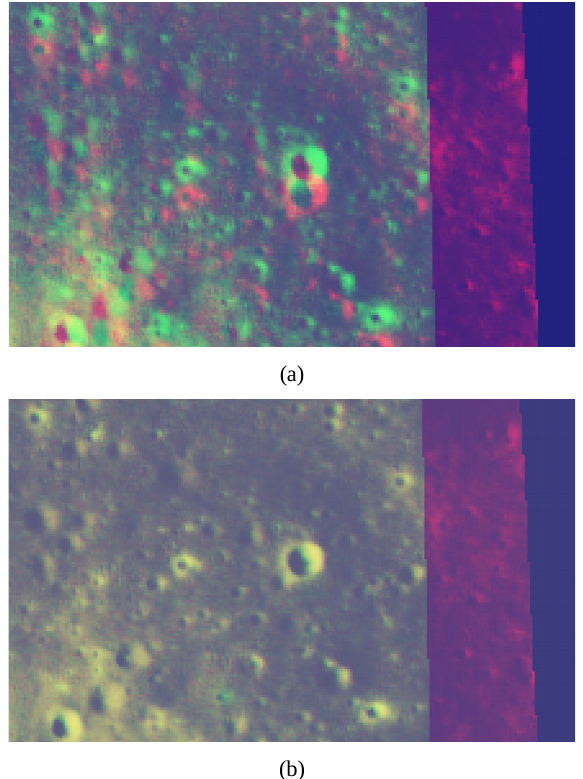
Figure 3: Image overlay of both NAC-L images acquired from different orbits (map projected and colored); red: M1159863525L; green: M1159877765L. (a) Before adjustment: Errors in the exterior orientation result in y-parallax of about eleven pixels and ambiguous feature locations. (b) After adjustment: The